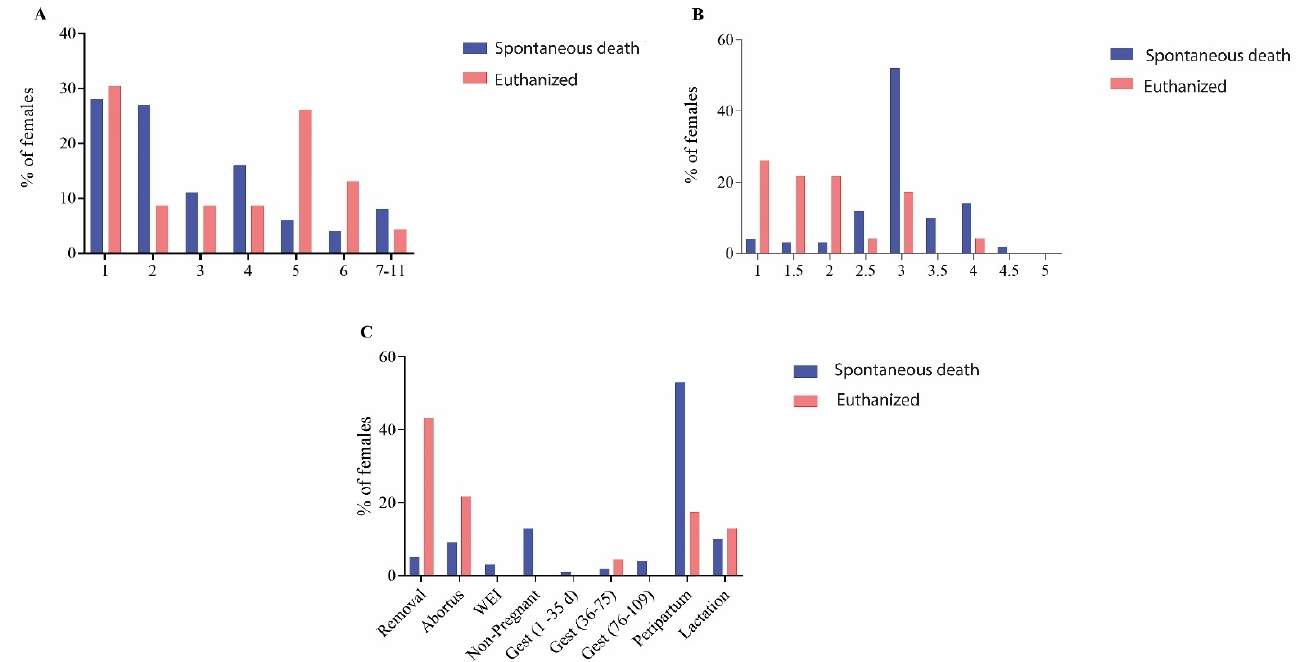
Figure 1. Characteristics of spontaneous death and euthanized females. ( A ) Parity order; ( B ) body